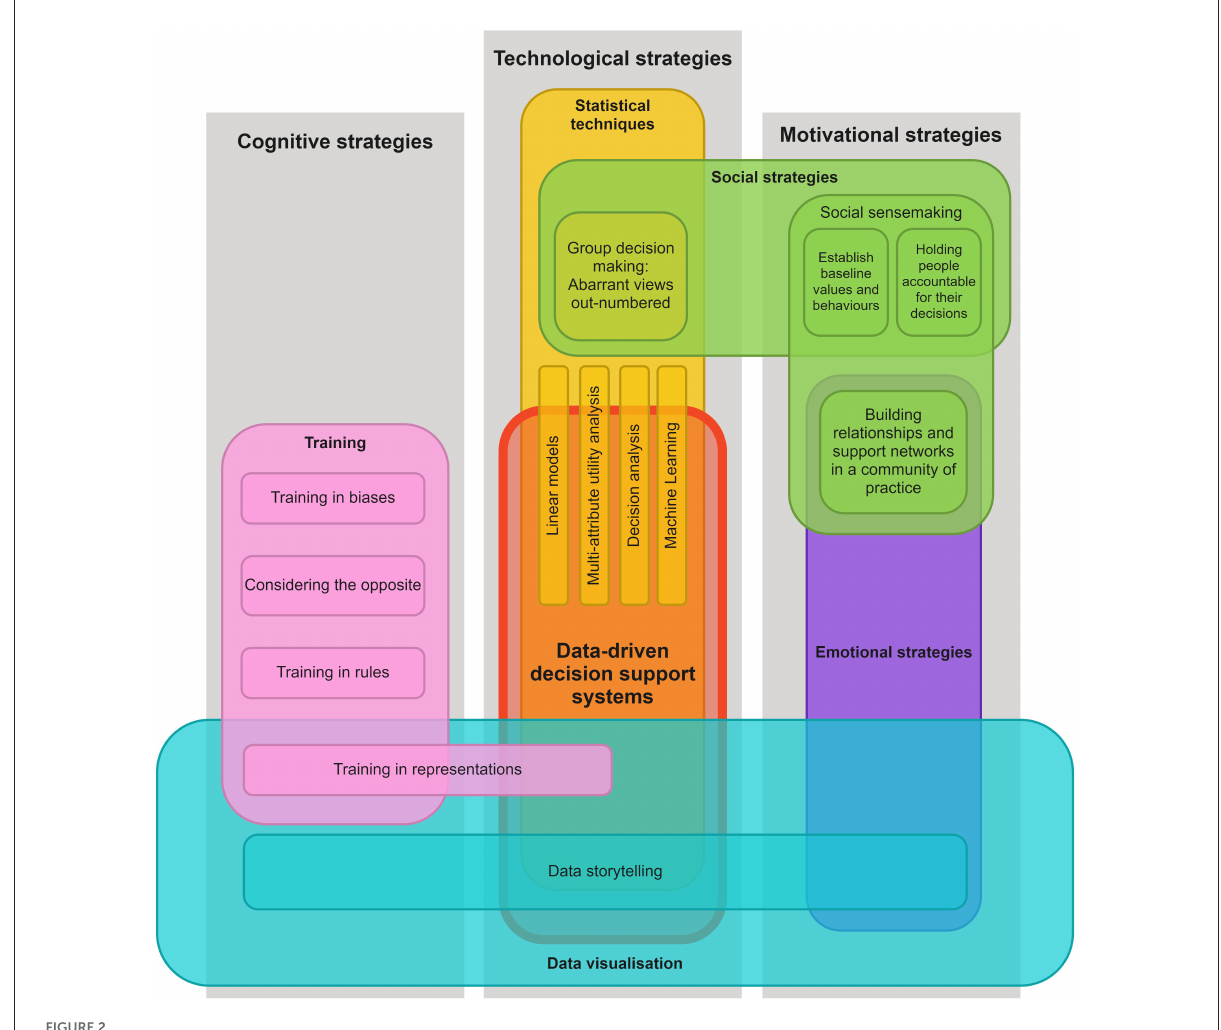
FIGURE2 Debiasing with data-driven technologies